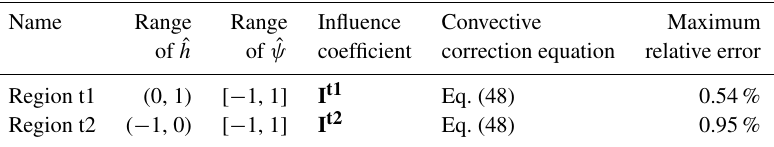
Table 2. The definition of the two regions for the parameter space of the equivalent relative position ˆ h , the normalized sweep angle ˆ ψ and the corresponding influence coefficients for the tangential induction. The equation of the convective correction and the maximum relative error of the fitted induction are also